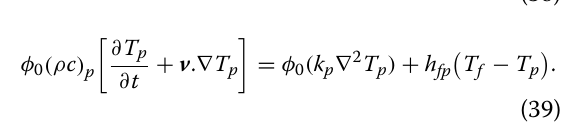
Fig. 8 Effect of alumina and copper nanoparticles on Rayleigh number in the presence of Hall effects